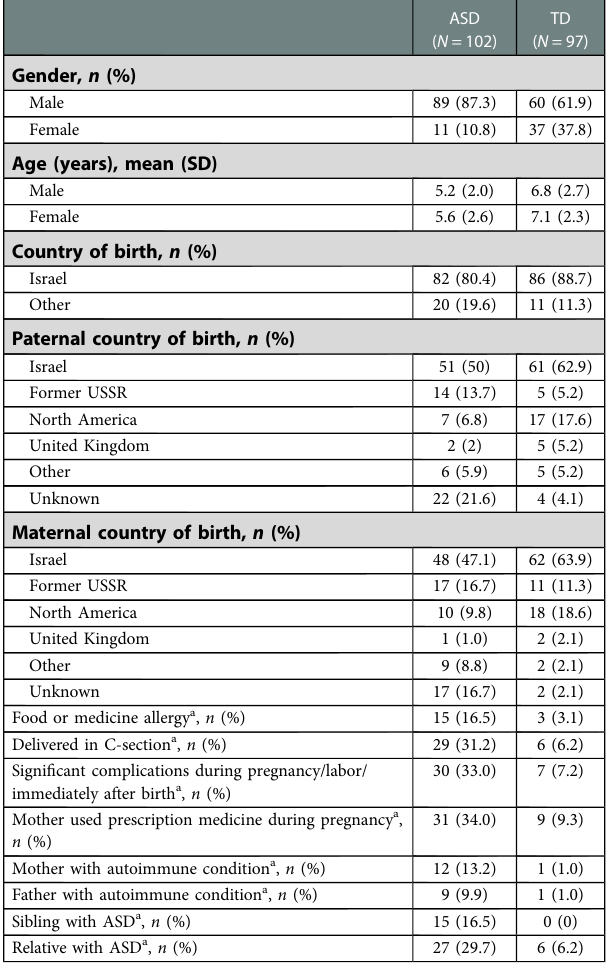
TABLE 1 Demographics and medical history of study